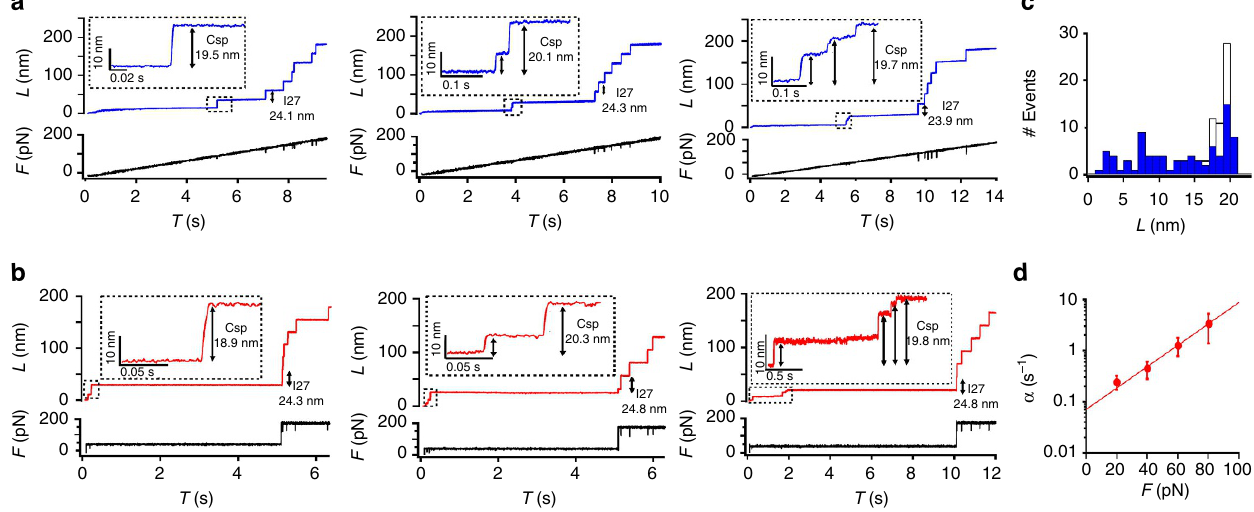
Figure 2 | Force-ramp and force-clamp experiments on Csp. ( a ) Three examples of force-ramp traces at 20pNs (cid:2) 1 in which the force is ramped until 300pN to trigger the final unfolding of the six I27 domains. ( b ) Three examples of force-clamp traces at 40pN for up to 10s followed by a jump to 150pN to trigger the unfolding of the six I27 domains. ( c ) Distribution of unfolding lengths of Csp intermediates obtained from force-ramp measurements (bin size 1nm). The total unfolding length from each trace is also shown as empty bars. ( d ) Semi-log plot of the unfolding rate ( a ) versus force (error bars in s.d.). With length ( L ), force ( F ) and time ( T ).